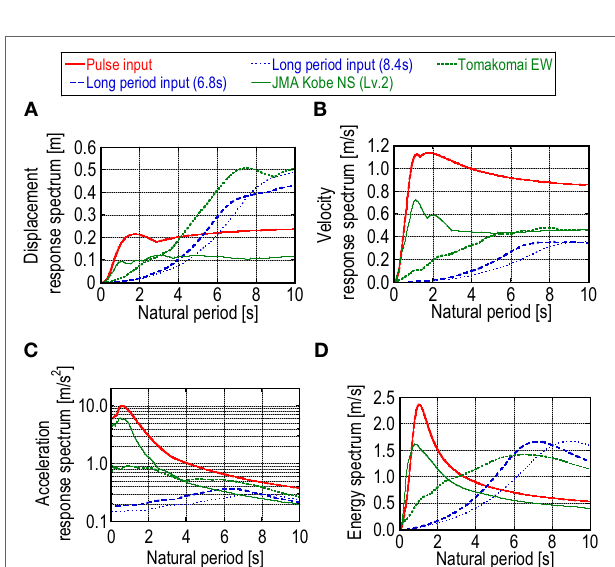
FIGURE 7 | Various spectra of five ground motions: (A) displacement response spectra, (B) velocity response spectra, (C) acceleration response spectra, and (D) energy spectra .